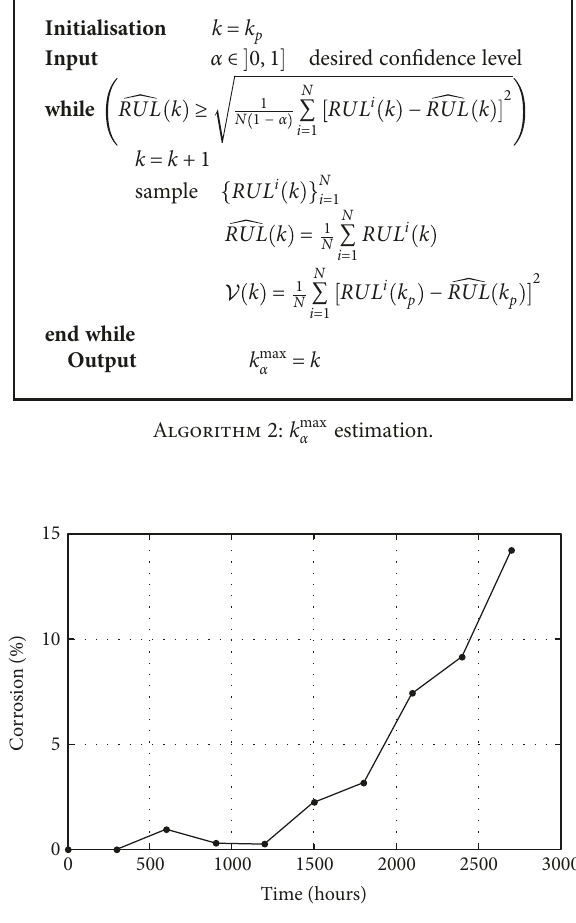
Figure 2: Degradation of polycrystalline silicon PV module under test 85/85.